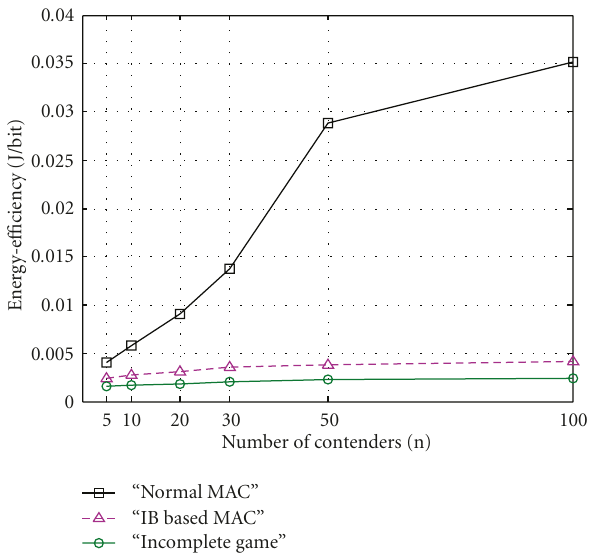
Figure 9: Energy-e ffi ciency versus number of nodes.